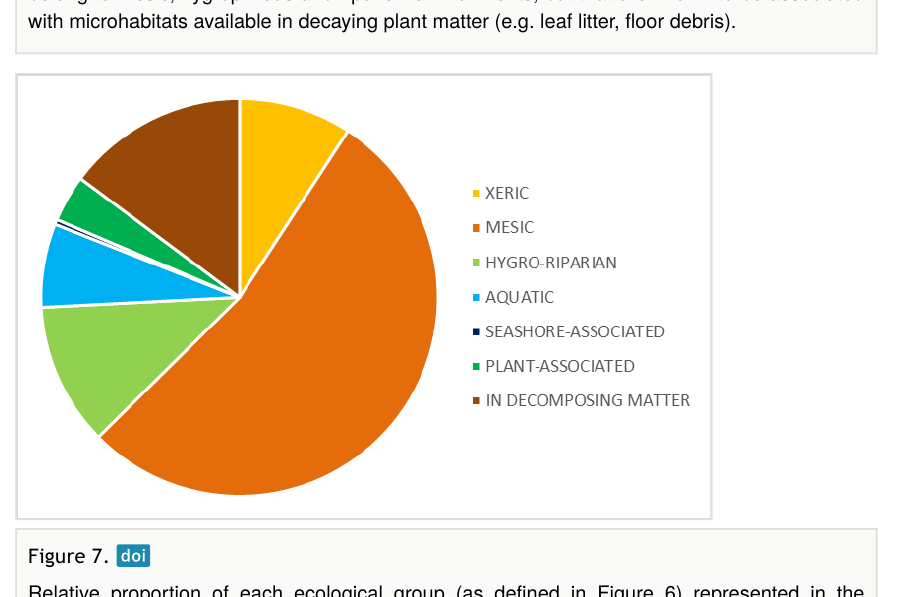
Relative proportion of each ecological group (as de fi ned in Figure 6) represented in the sample. Percentages were calculated on the basis of the total number of Coleoptera within the